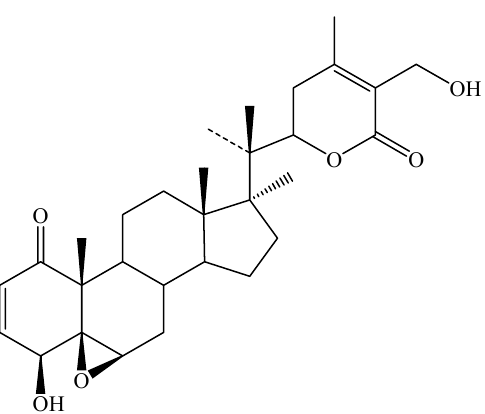
Figure 3. Structure of withaferin A.